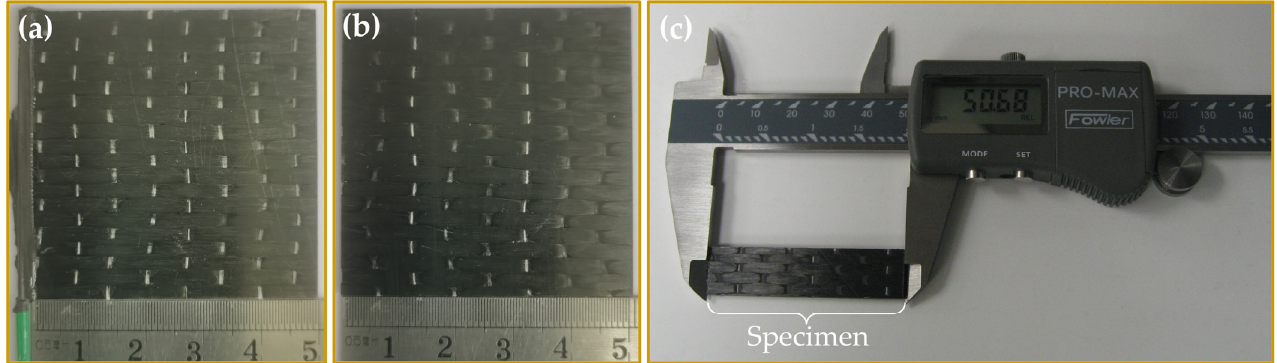
Figure 1. The macrosopic specimens used for ( a ) EIS test; ( b ) weight gain test; ( c ) mechanical prop- erty test. property